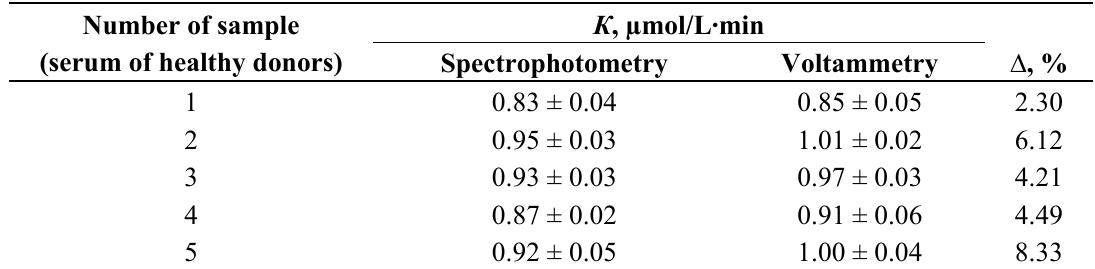
Table 2. Values of the TAA of human serum blood under physiological conditions, calculated by the kinetic coefficient, measured by two various